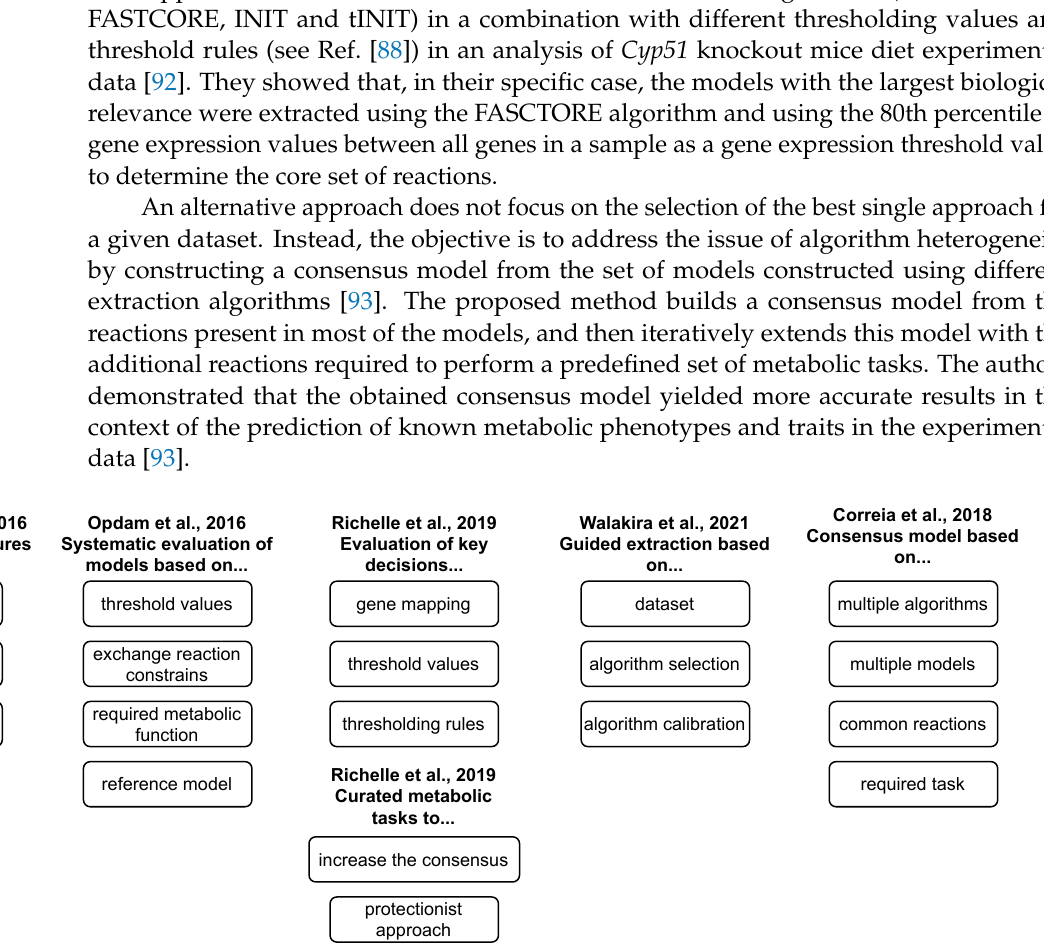
Figure 3. An overview of selected benchmarks and protocols to guide the extractions of context- specific models